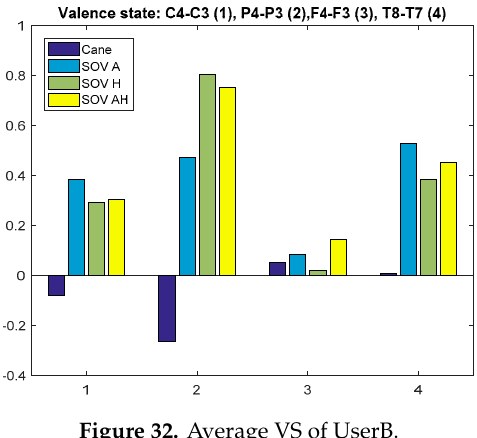
Figure 32. Average VS of UserB.